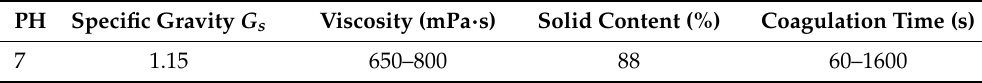
Table 2. The properties of the polymer stabilizer.